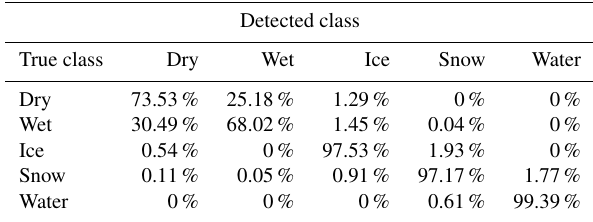
Table 8. Confusion matrix of